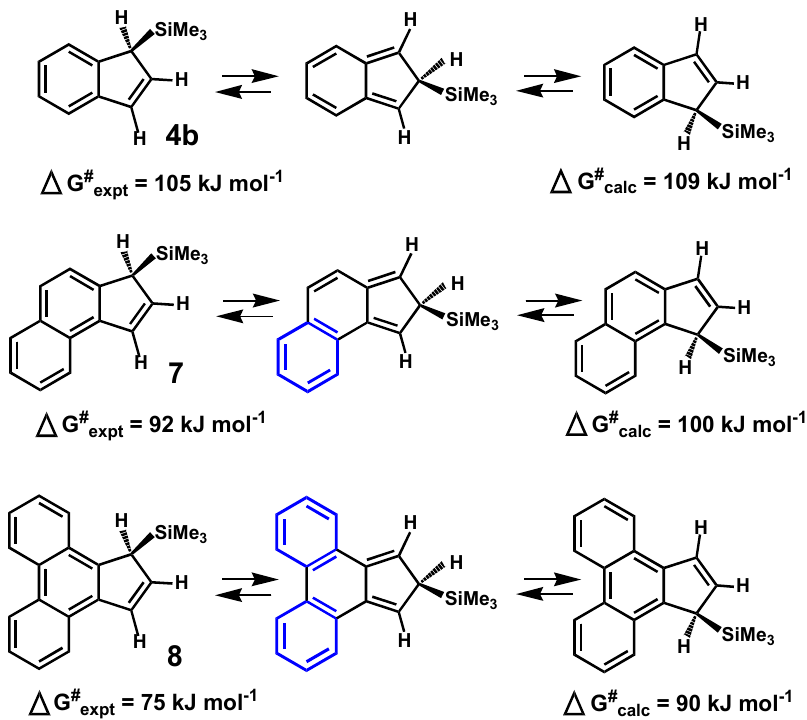
Figure 1. Calculated and experimental barriers to silatropic shifts in a series of benzindenes.